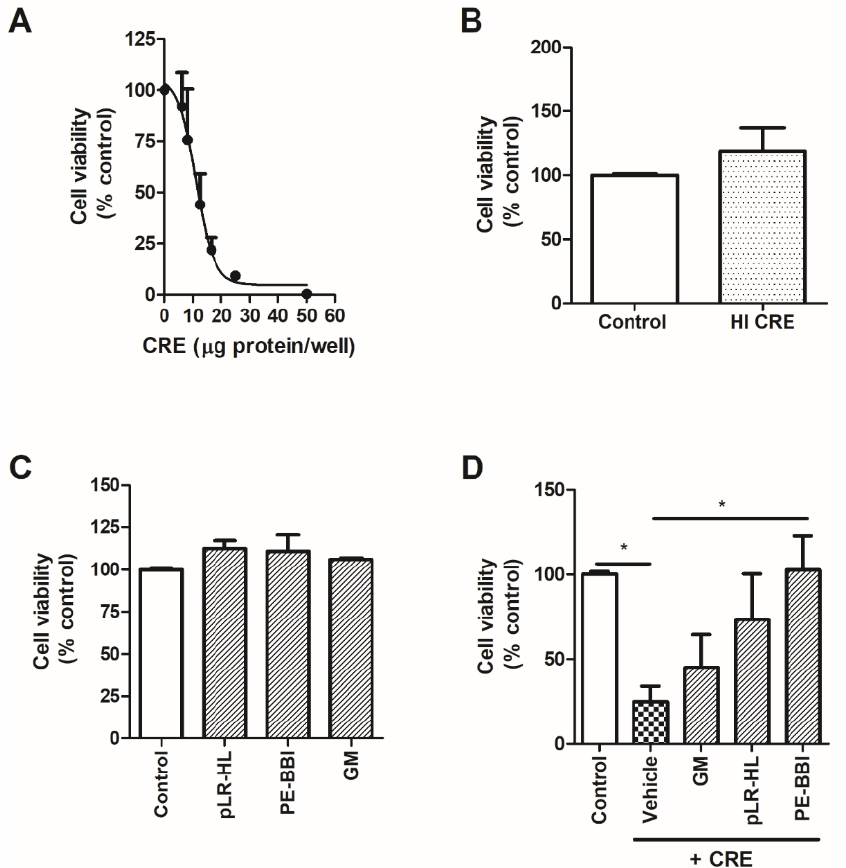
Figure 3. The effect of protease inhibitors on cockroach-mediated cell death (submerged 16HBE cells). ( A ) Addition of cockroach extract resulted in reduced cell viability in a dose-dependent manner. ( B ) Heat-inactivated cockroach extract (75 °C, 3 min), which completely abolishes proteolytic activity, does not affect cell viability when added at a high dose (50 µg/well). ( C ) Cell viability was unaltered by protease inhibitors added alone (at a 50 µM dose for 24 hr). ( D ) Cockroach extract (16.5 µg/well, 24 h) significantly elicited decreased cell viability that was rescued by co-administration of PE-BBI but not pLR-HL or GM (all added at a 50 µM dose). Data are presented as the mean ± SEMs (n = 6). * P < 0.05.